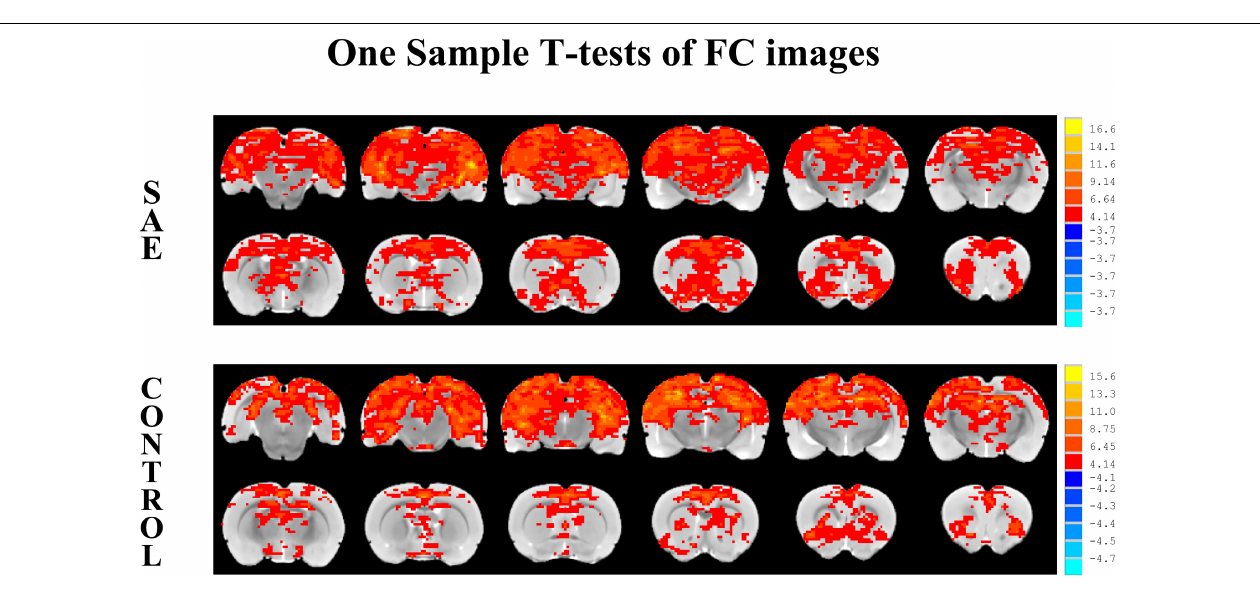
FIGURE 2 | Illustration of one-sample t -tests results of the hippocampus functional connectivity (FC) maps in the SAE and control groups, the seed is the bilateral